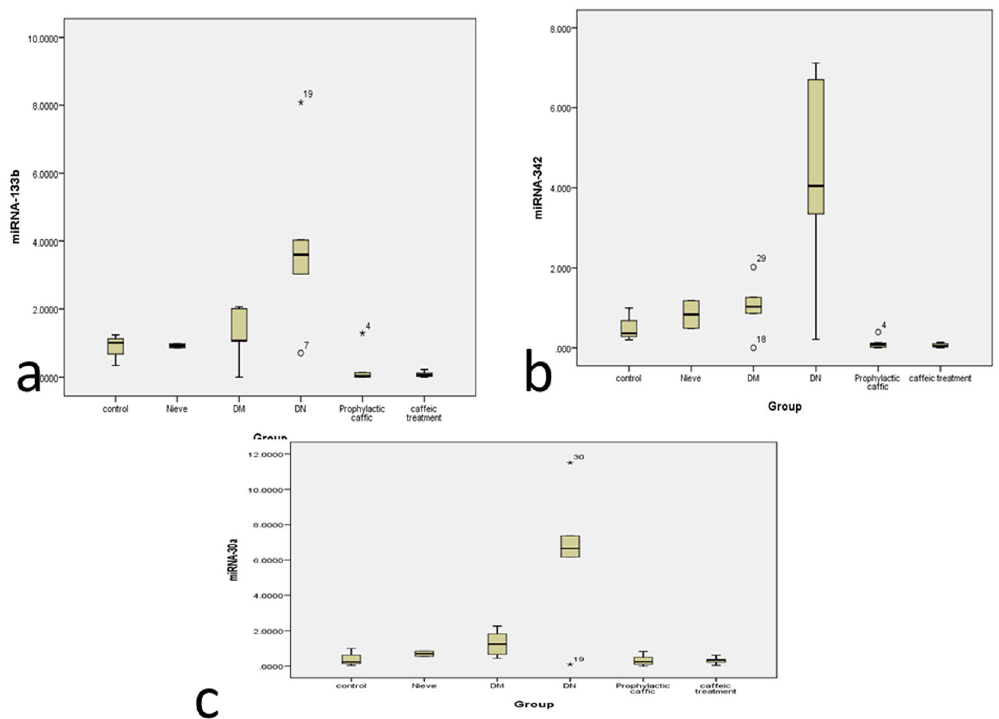
Figure 5. miR-133b, -342, 30a expression in Kidney tissue at the end of the 12 weeks in the Control, naïve, Diabetes mellitus group, Diabetic nephropathy group, caffeic acid Prophylactic group, caffeic acid Treated group. ( A ) miR-133b; ( B ) miR-342; ( C ) miR-30a. Data are presented as fold change, where * indicates P < 0.05 compared to the control group (One way ANOVA followed by Bonferroni’s multiple comparison test), N =